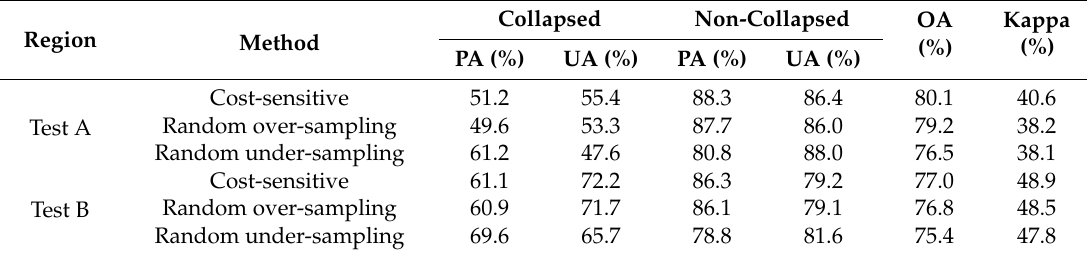
Table 4. The performance of balancing methods on test A and test B